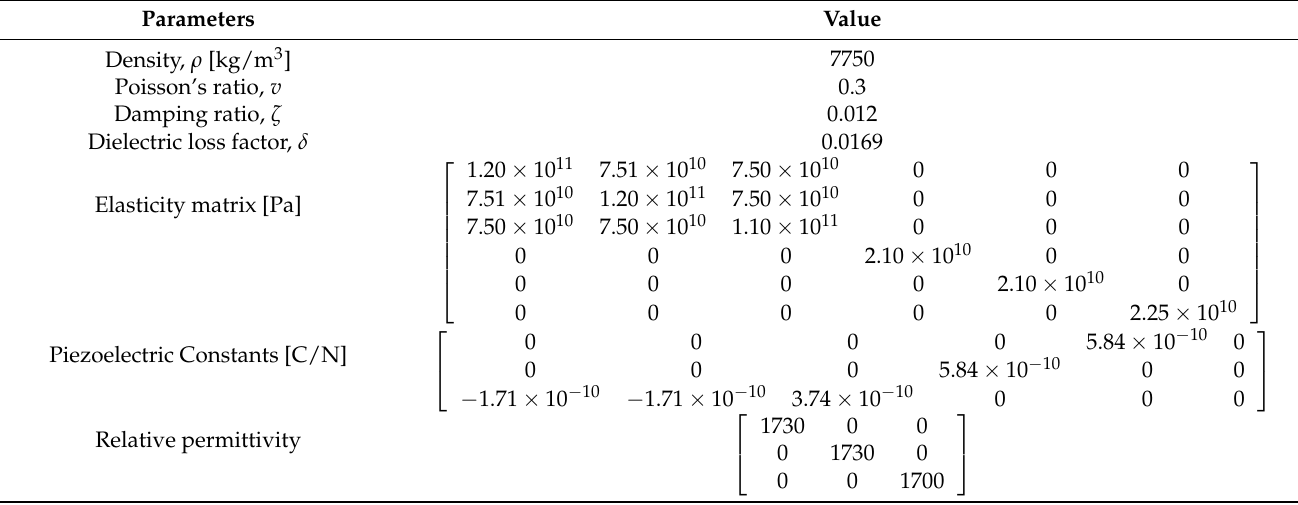
Table 1. Material properties of PZT patch.